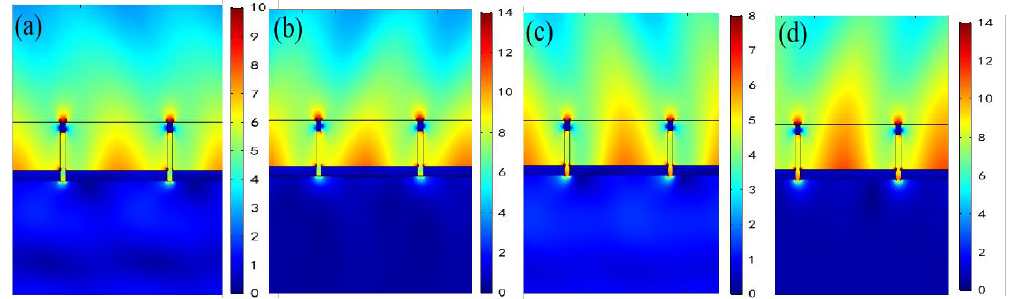
Figure 11. Electric field distributions of the first reflection resonant dip for TM polarized incidence from the bottom and the top at θ = 20° and θ = 30°. ( a ) = 924 nm on the bottom for θ = 20°; ( b ) = 924 nm on the top for θ = 20°; ( c ) = 1062 nm on the bottom for θ = 30°; ( d ) = 1062 nm on the top for θ = 30°.